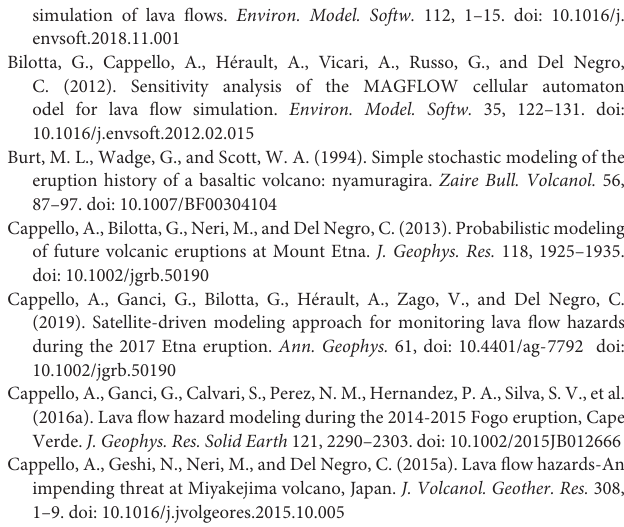
TABLE S1 | Date (dd/mm/yyy), duration (in hours), lava volume (in m 3 ), Mean Output Rate (in m 3 /s), cumulative volumes (in m 3 ) and the eruptive class identity of SEC eruptions occurred between September 1998 and August 2018. Eruptive classes are numbered from 1 to 9 depending on duration and volume emitted: class 1 ( < 4 h, < 1 × 10 6 m 3 ), class 2 (between 4 and 8 h, < 1 × 10 6 m 3 ), class 3 ( > 8 h, < 1 × 10 6 m 3 ), class 4 ( < 4 h, between 1 and 2 × 10 6 m 3 ), class 5 (between 4 and 8 h, between 1 and 2 × 10 6 m 3 ), class 6 ( > 8 h, between 1 and 2 × 10 6 m 3 ), class 7 ( < 4 h, > 2 × 10 6 m 3 ), class 8 (between 4 and 8